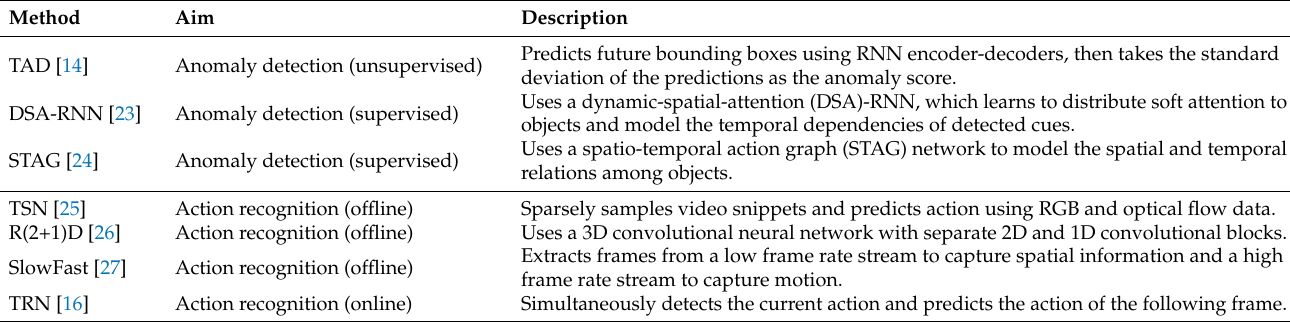
Table 1. Video-based anomaly detection and action recognition methods. TRN, temporal recurrent network.